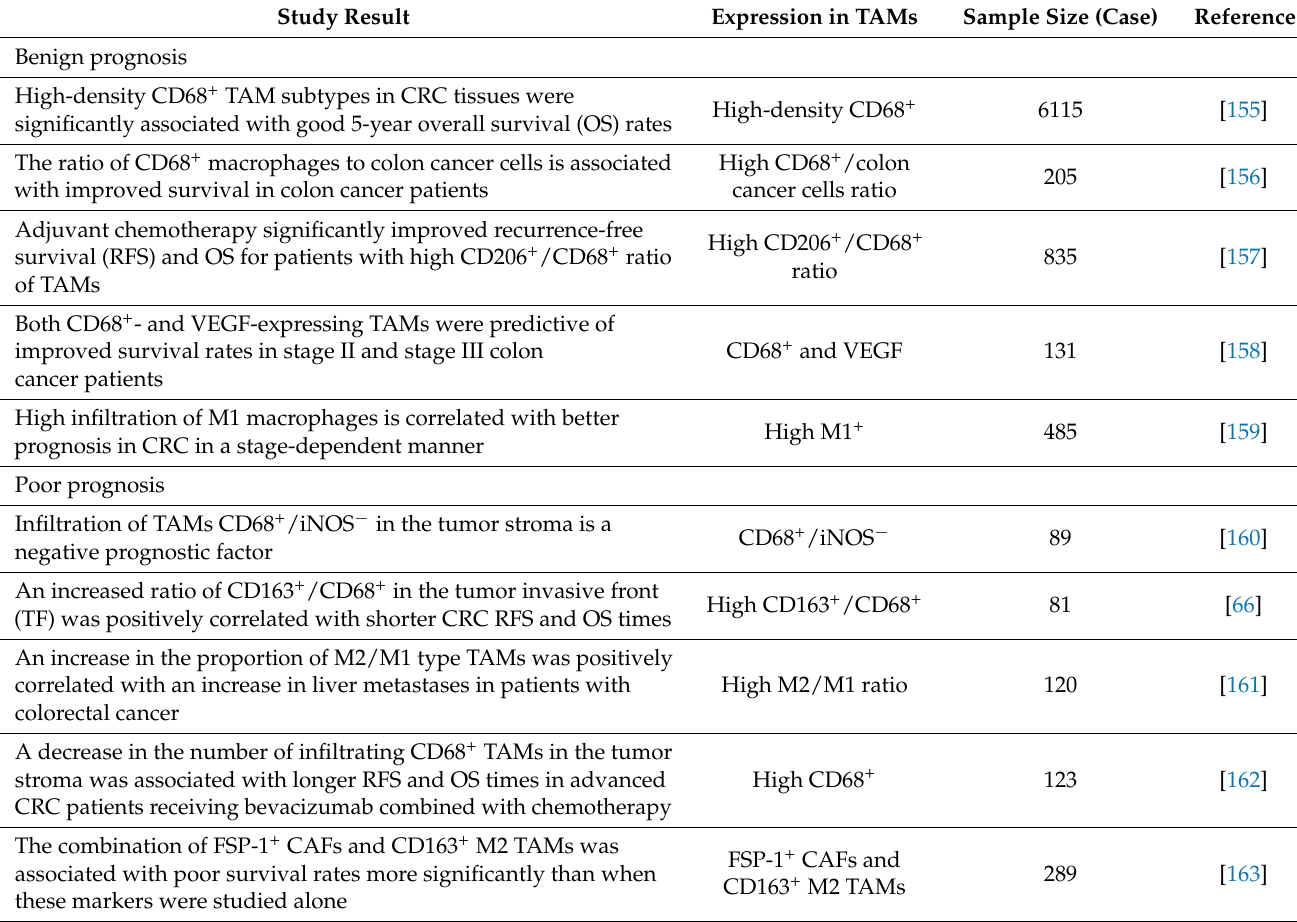
Table 1. Literature reports on the associations between TAMs and the prognosis of CRC